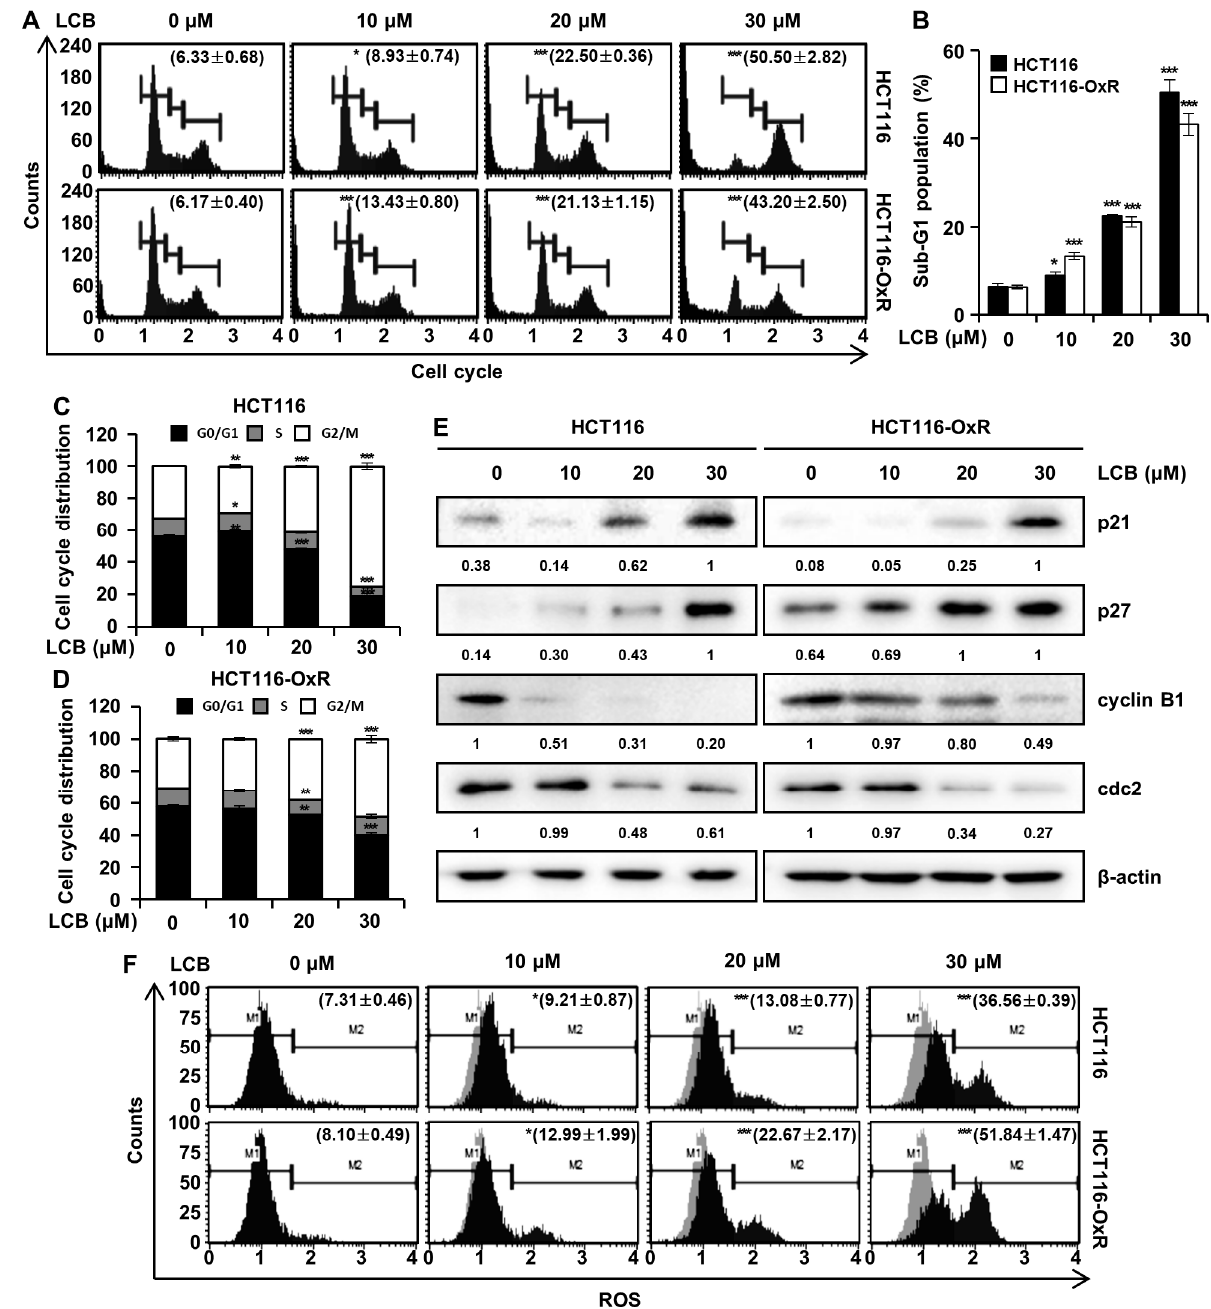
Figure 3. LCB induced G2/M cell cycle arrest in CRC cells. HCT116 and HCT116-OxR cells were treated with LCB for 48 h. ( A ) Cell cycle was detected by flow cytometry. ( B ) Bar-graphical repre- sentation of the sub-G1 population. ( C , D ) Cell cycle distribution of HCT116 and HCT116-OxR cells by flow cytometry. ( E ) Western blotting with antibodies to determine cell-cycle-related proteins, including cyclin B1, cdc2, p21, and p27. β -actin was used to confirm equal loading of protein samples. ( F ) ROS production was detected by flow cytometry after treatment of CRC cells with LCB for 48 h. * p < 0.05, ** p < 0.01, *** p < 0.001 versus the untreated control.